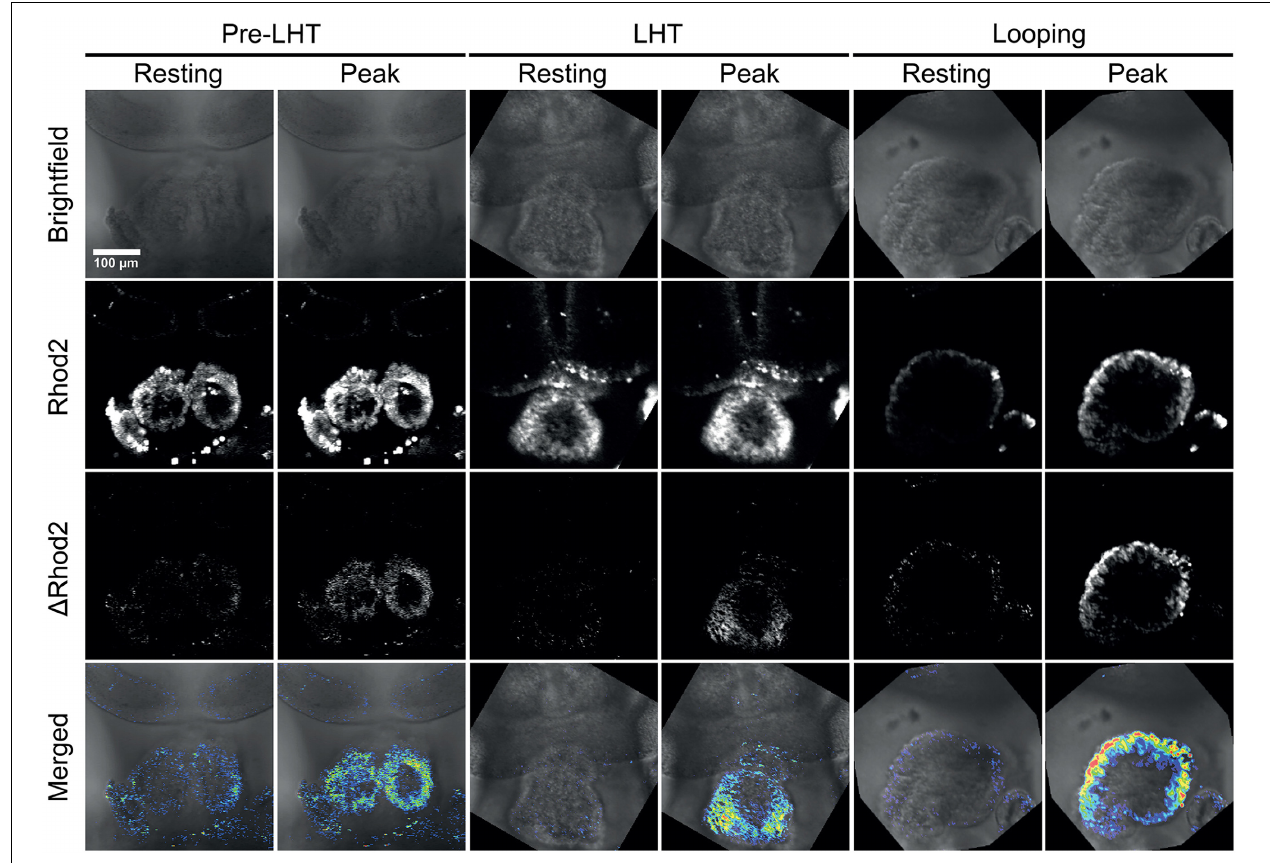
pericardial sac was removed to allow entry of the Ca 2 + sensitive dye Rhod-2. The scale bar represents 100 microns. Also see Supplementary Movie 3